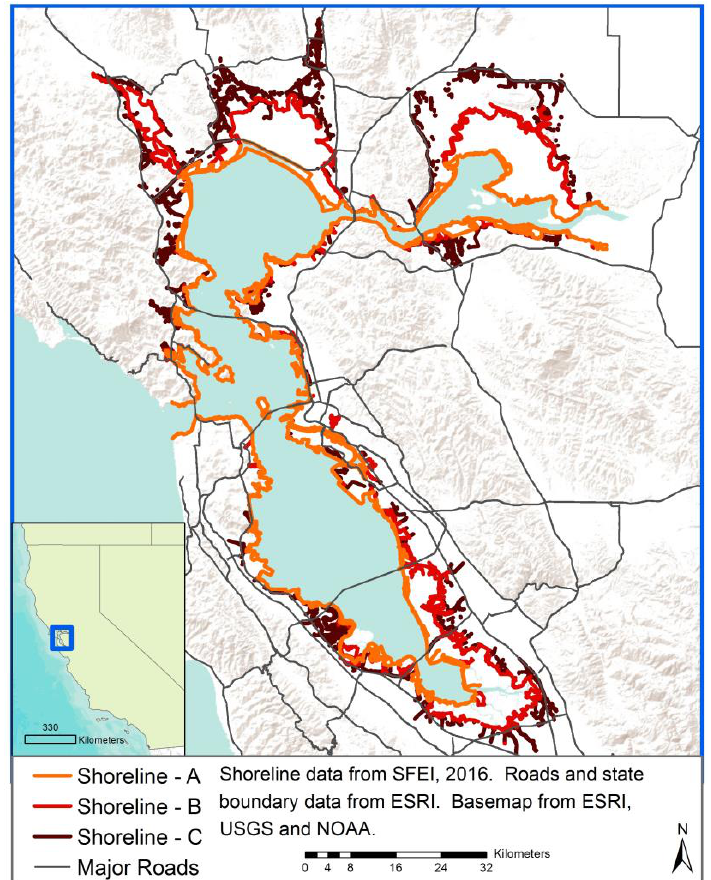
Figure 3. Map showing the full San Francisco Bay study area and the location of the three different shorelines—A, B, and C—we designated for comparative analysis purposes.